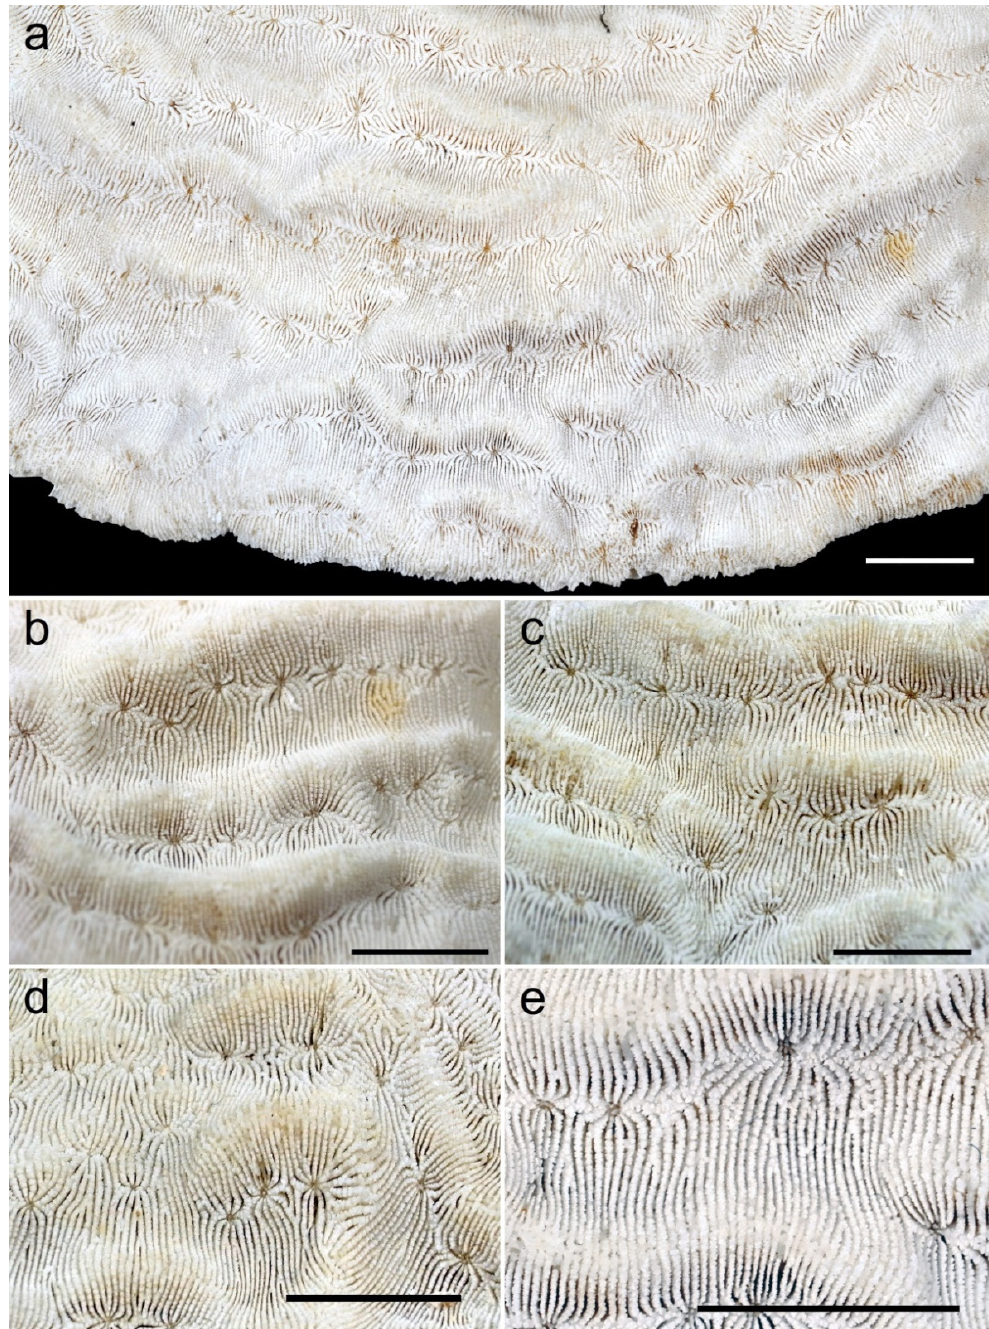
Figure 2. Coscinaraea marshae. Details of coral skeleton fragments ( a – e ) of a specimen illustrated alive (Figure 1a,b) in Sarabua Bay, Siberut Island, West Sumatra, Indonesia. Scale bars: 1 cm.